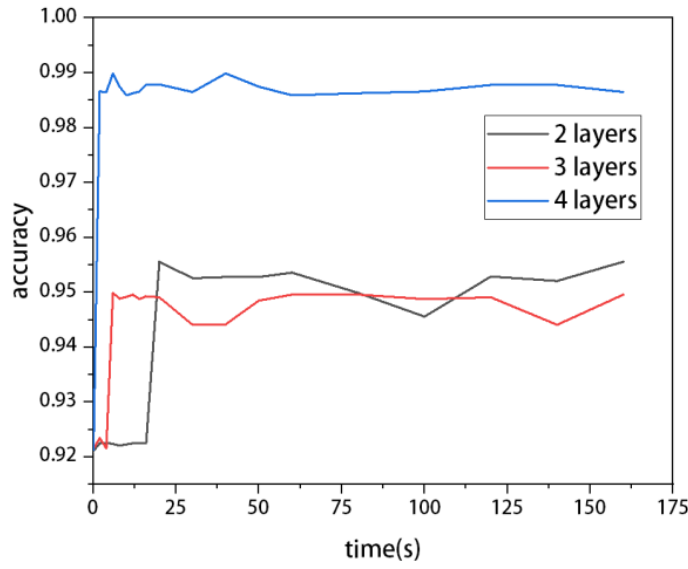
Figure 7. Accuracy of different numbers of layers of LSTM in the training dataset.